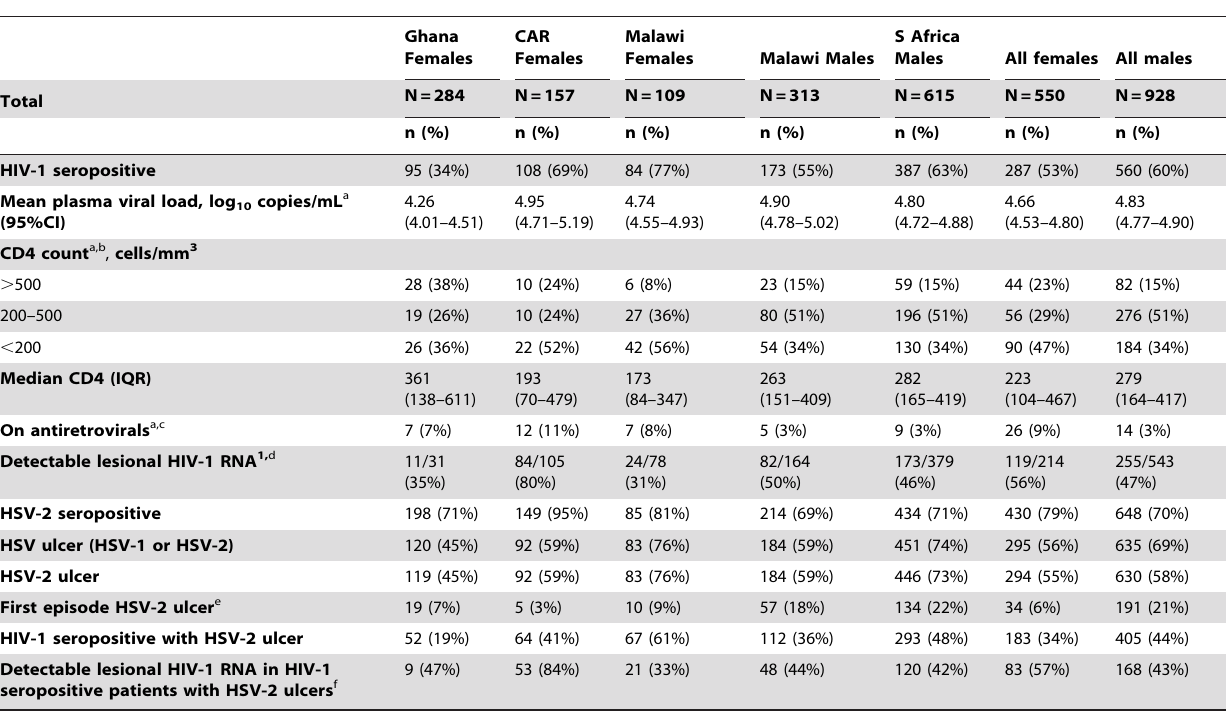
Table 3. HIV/HSV-related characteristics of trial participants with genital ulcer disease (GUD) at enrolment, by country & sex.